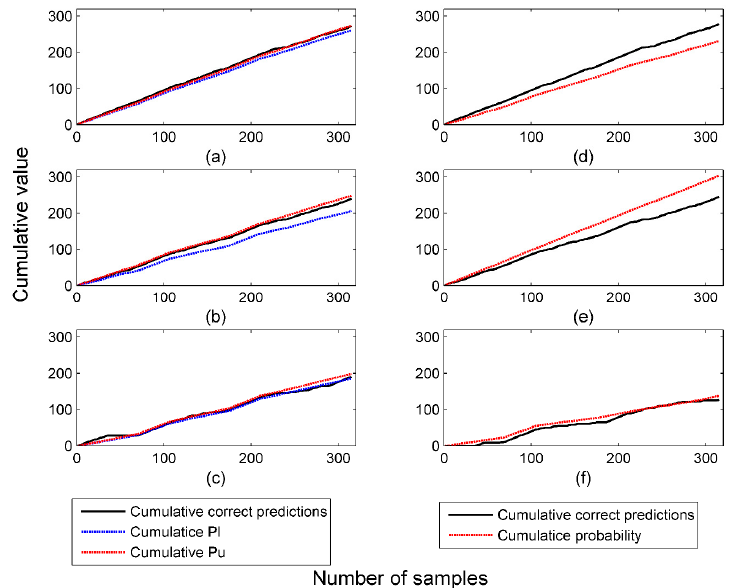
Figure 2. Validity of probabilistic predictions by ( a ) VM-SVM; ( b ) VM-SR; ( c ) VM-NB; ( d ) Platt’s method; ( e ) Softmax Regression; and ( f ) Naïve Bayes in offline mode.